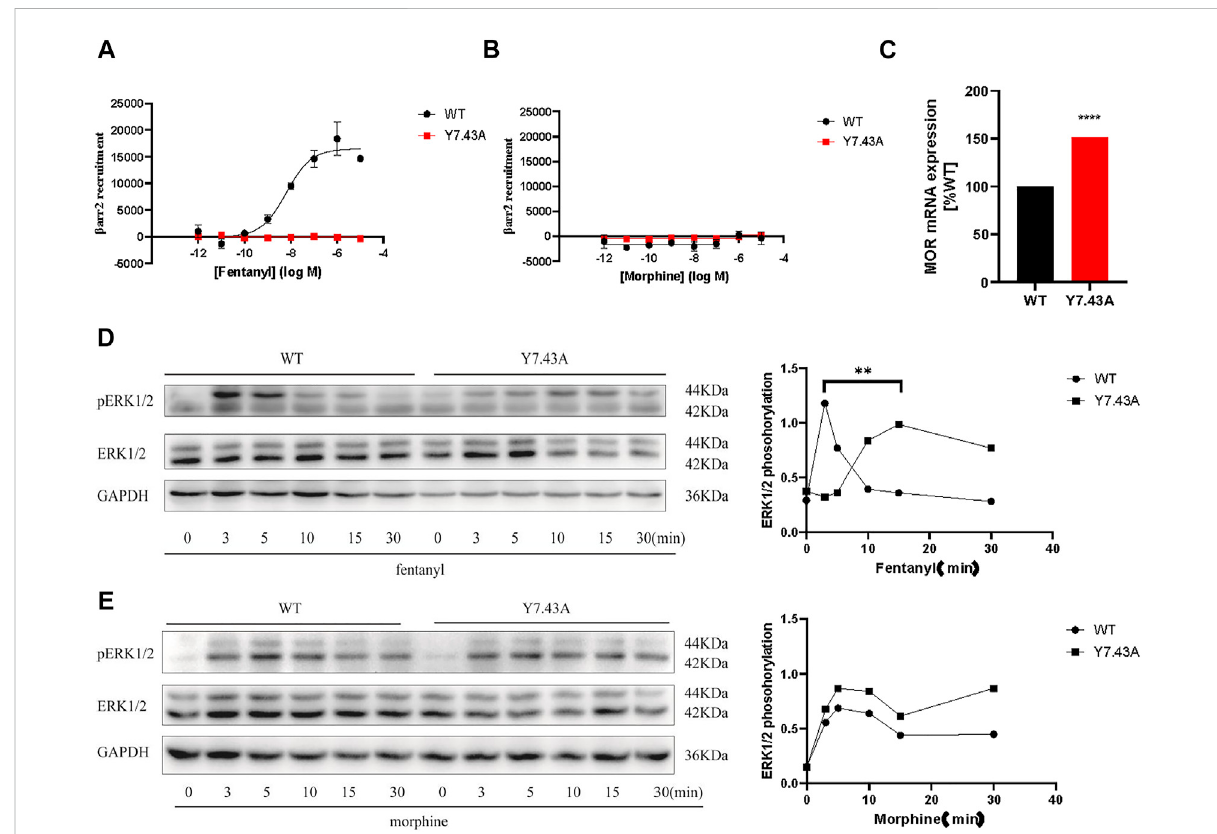
FIGURE 3 Effect of ß -arrestin2 recruitment stimulated by fentanyl and morphine in wild type (WT) and Y7.43A mutant µ-opioid receptor (MOR). (A,B) dose – response curves for fentanyl- and morphine-induced ß -arrestin2 recruitment for WT (fentanyl: EC 50 = 6.75 ± 2.01 nM, E max = 16,521.33 ± 1446.39) and Y7.43A mutant MOR transfected cells. (C) receptor cell surface expression via quantitative real-time polymerase chain reaction assay. Datarepresentedasmean±standarderrorofthemeanfromthreeindependentexperiments;thestatisticalsigni fi canceofdifferencesbetween WT and Y7.43A mutant MOR analyzed using an unpaired two-tailed t -test ( p **** < 0.0001). (D,E) representative western blots and quanti fi cation of ERK1/2 phosphorylation by WT and Y7.43A mutant MOR before ( − ) and after (+) stimulation by (D) fentanyl and (E) morphine in a time-course experiment; GAPDH used as a loading control; the quanti fi cation of ERK1/2 phosphorylation refers to the pERK/ERK ratio. * indicates statistically signi fi cant differences at the peak time point of ERK1/2 activation compared with